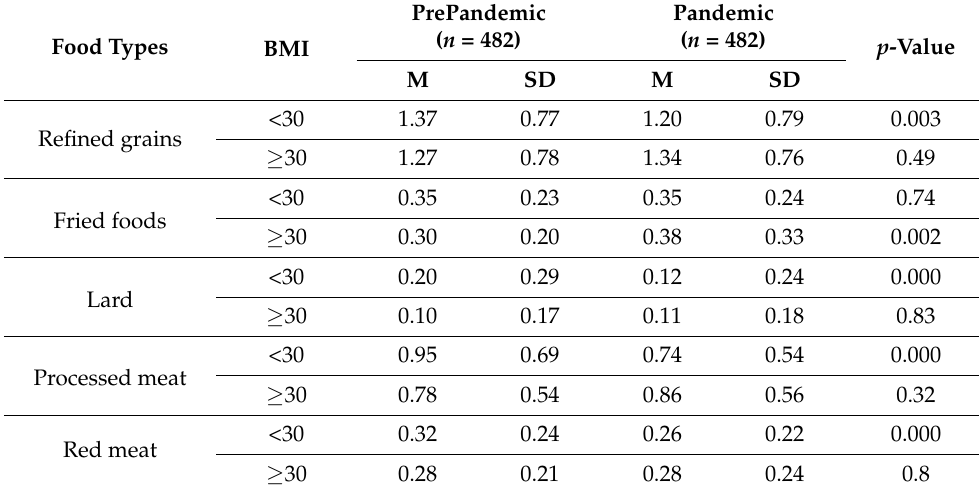
Table 8. Changes in the consumption frequency of selected foods from the Non-Healthy Nutrition Indicator during the